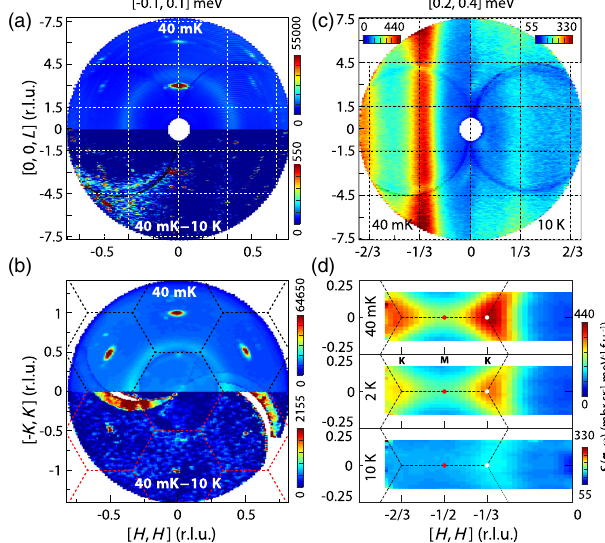
FIG. 2. Neutron scattering results in ½ H; H; L (cid:3) and ½ H; K; 0 (cid:3) zones. Elastic neutron scattering results ( E ¼ 0 (cid:2) 0 . 1 meV) in (a) the ½ H; H; L (cid:3) plane and (b) ½ H; K; 0 (cid:3) plane measured with E i ¼ 3 . 32 and 3.70 meV, respectively. Scattering along the vertical direction [ ½ − K; K; 0 (cid:3) for (a) and ½ 0 ; 0 ; L (cid:3) for (b)] is integrated. The upper half panels of (a) and (b) are data at T ¼ 40 mK, and the lower are the differences between T ¼ 40 mK and 10 K. (c) L dependence of the spin excitations along the ½ H; H (cid:3) direction at T ¼ 40 mK (left half panel) and T ¼ 10 K (right half panel), with K ¼ ½ − 0 . 05 ; 0 . 05 (cid:3) and E ¼ 0 . 3 (cid:2) 0 . 1 meV. (d) Spin excitations with E ¼ 0 . 3 (cid:2) 0 . 1 inthe ½ H; K (cid:3) plane measuredat T ¼ 40 mK, 2, and 10 K. Scattering along the ½ 0 ; 0 ; L (cid:3) direction is integrated. The black dashed lines mark the Brillouin zones of NaYbSe 2